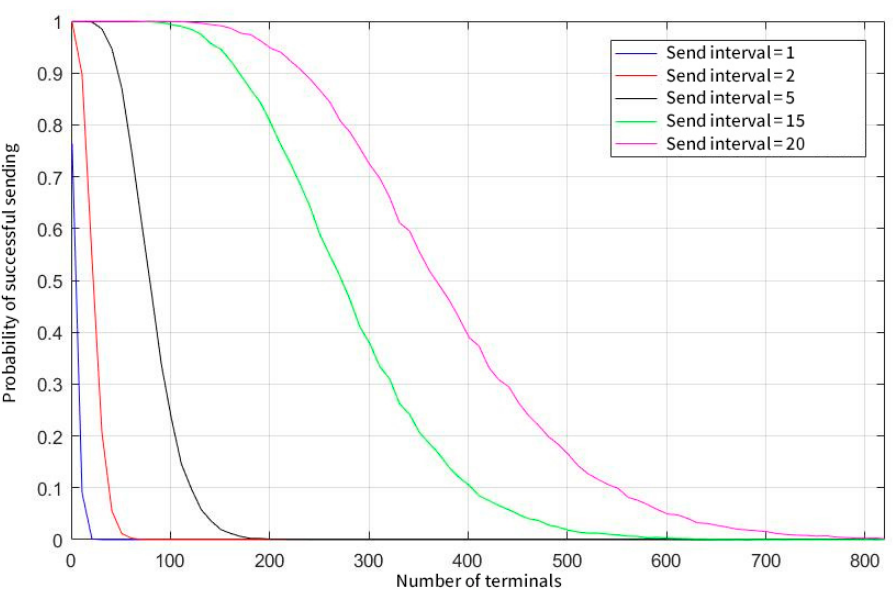
Figure 10. Statistics of successful sending probability at different sending intervals (concurrent demodulation thresholds equal to 10).